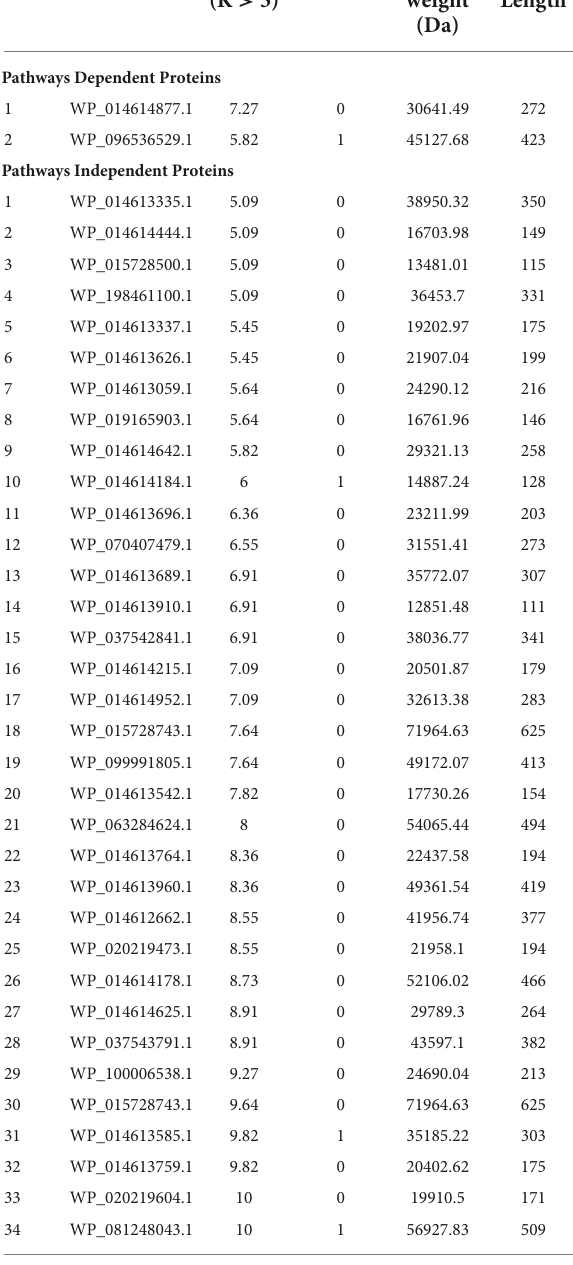
TABLE 2 Metabolic pathways dependent and independent potential drug target proteins of S. pseudintermedius. Sr No. Protein